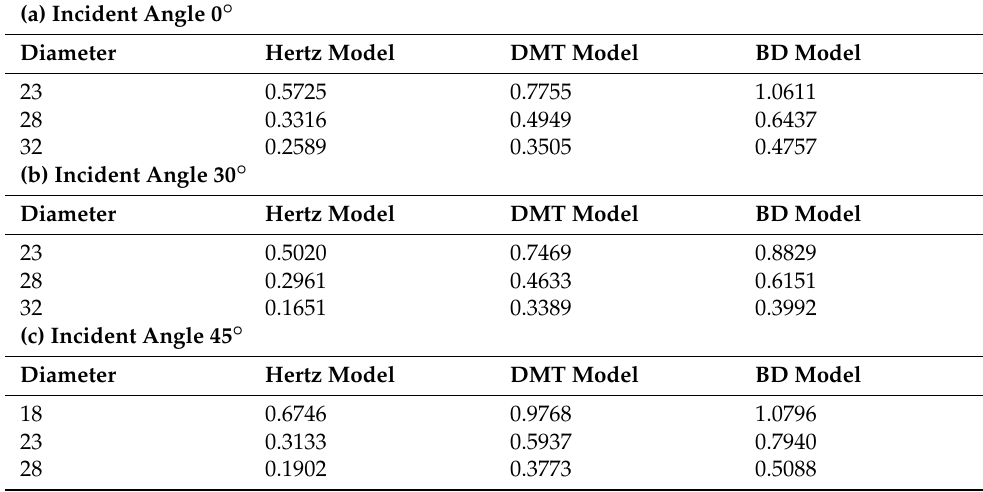
Table 4. The critical capture velocity of Hertz model, DMT model, and BD model at different incident